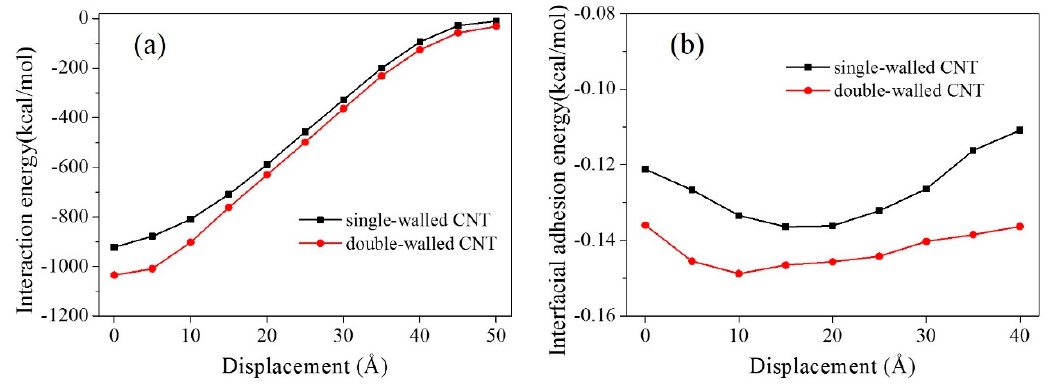
Figure 12. Interaction energies and interfacial adhesion energies for the composite models with a single-walled CNT and a double-walled CNT.